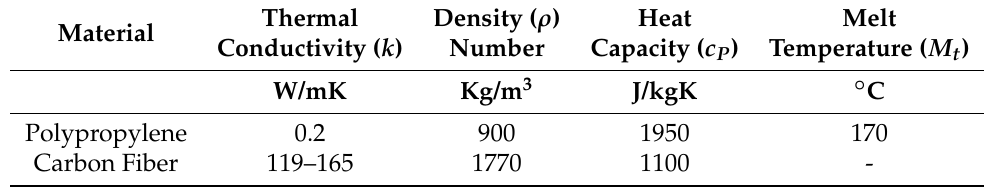
Table 1. Properties for